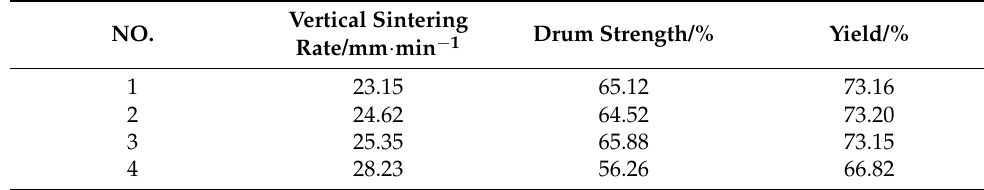
Table 5. Sintering technical indexes.